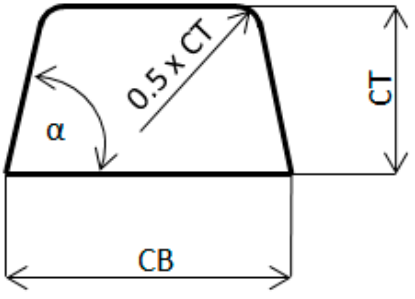
Figure 2. Cross section of the gating